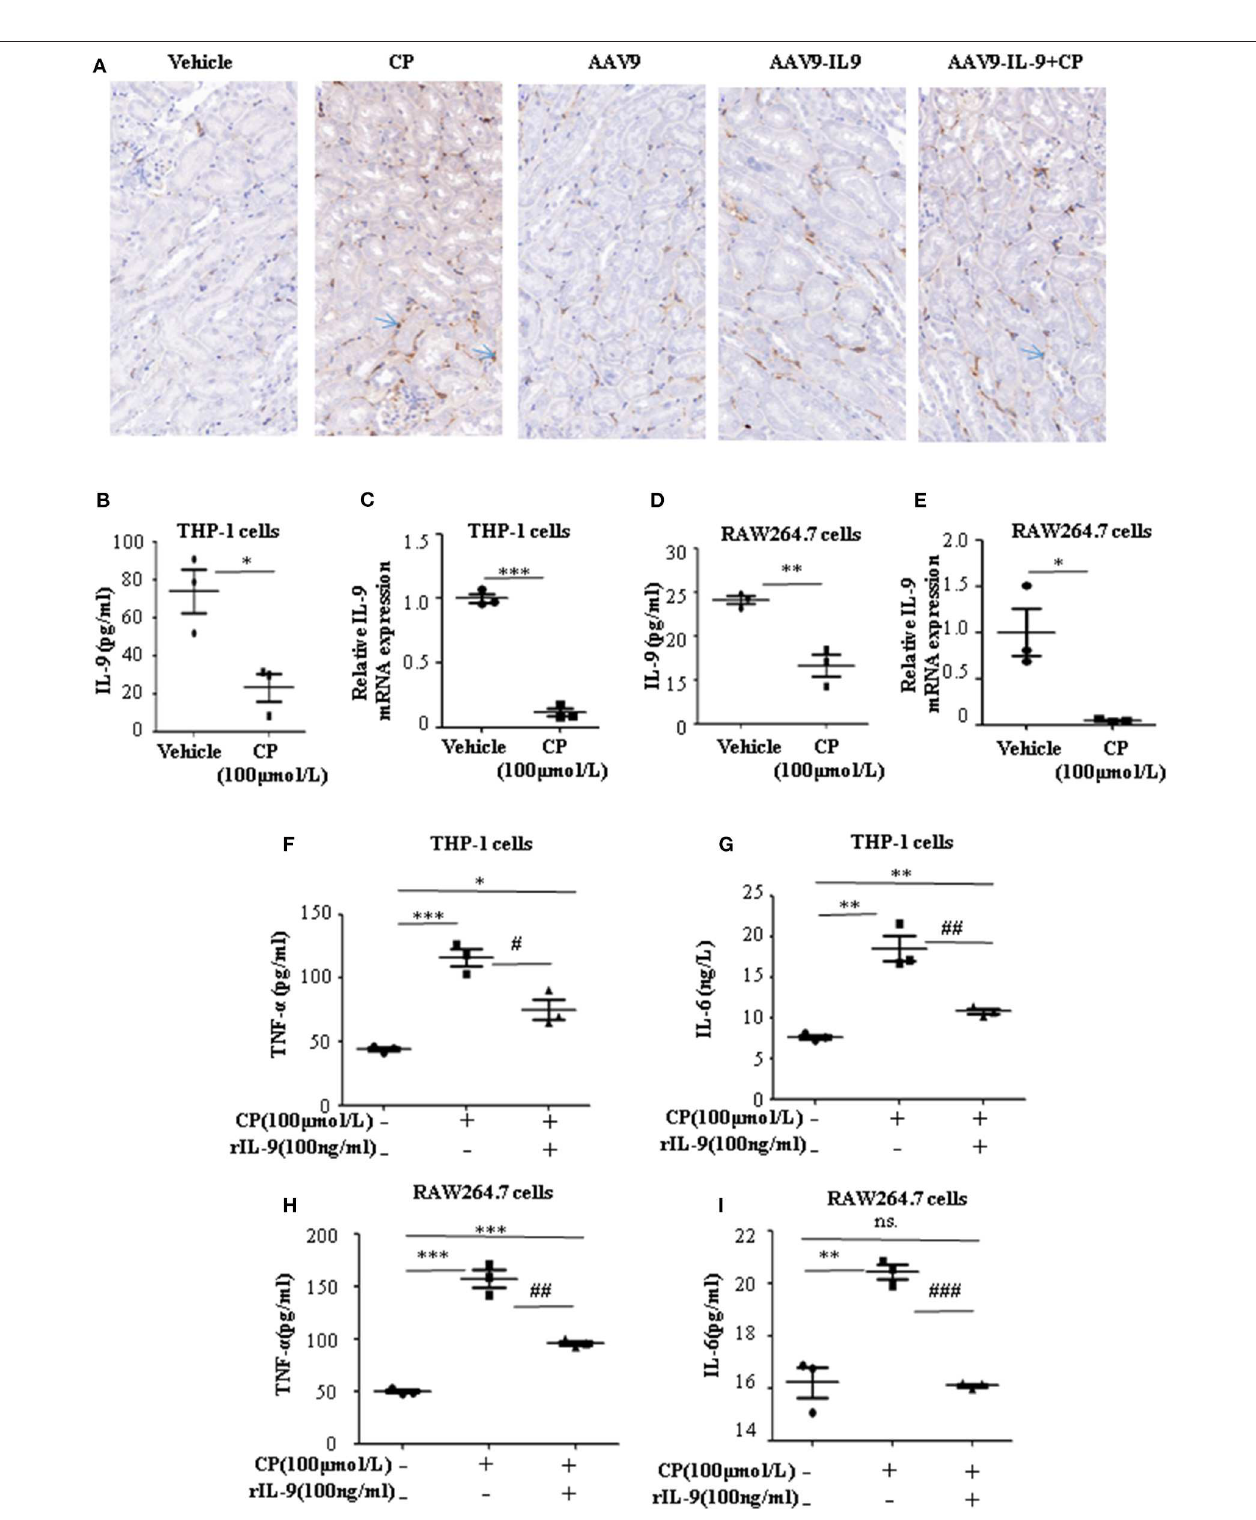
FIGURE 3 | Interleukin-9 (IL-9) suppressed the pro-inflammatory cytokines associated with macrophages in vivo and in vitro . Data were represented as mean ± SD of three independent experiments. (A) Representative images of immunohistochemistry staining infiltrated macrophages of different groups of mice. Mice were injected with adeno-associated virus 9 (AAV9)-IL9 vectors by tail vein injections to confirm the overexpression of IL-9 in the kidneys then induced by cisplatin (CP) (20 mg/kg)